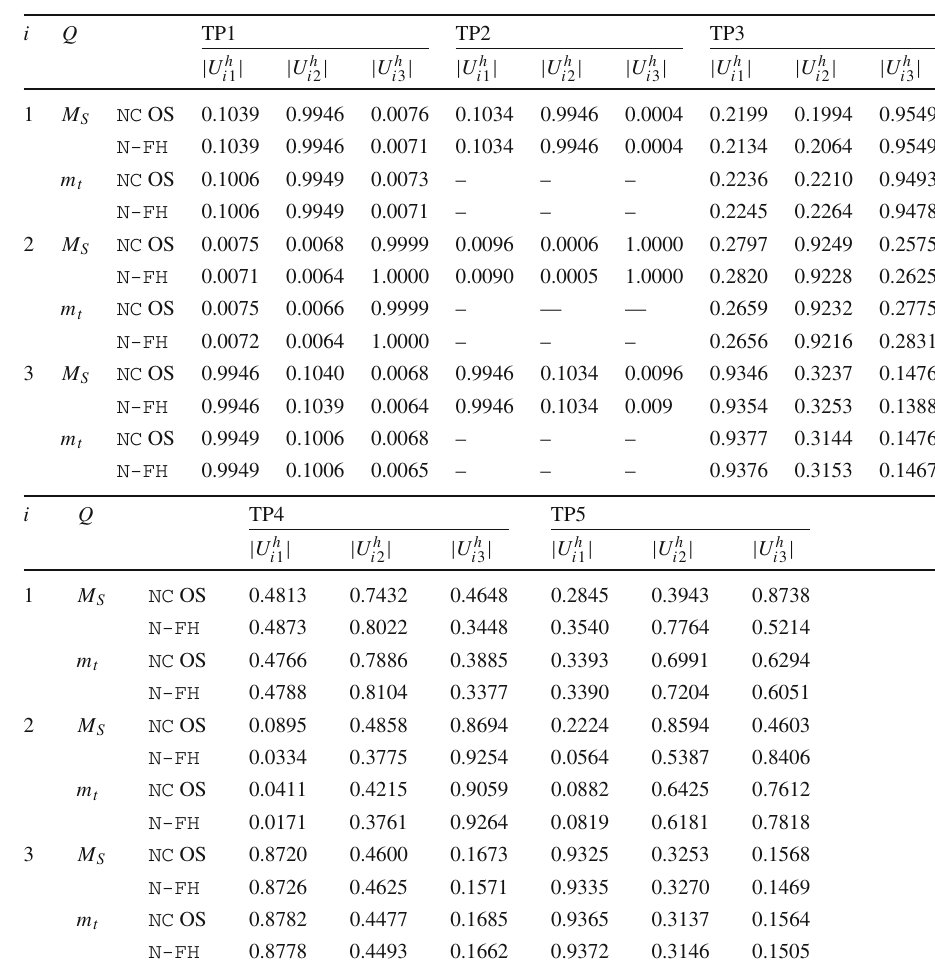
Table 5 Absolute values for the mixing-matrix elements of the CP -even scalar sector for TP1–TP5 when using the indicated versions of NMSSMCALC and NMSSM-FeynHiggs as specified in the text; see Sect.